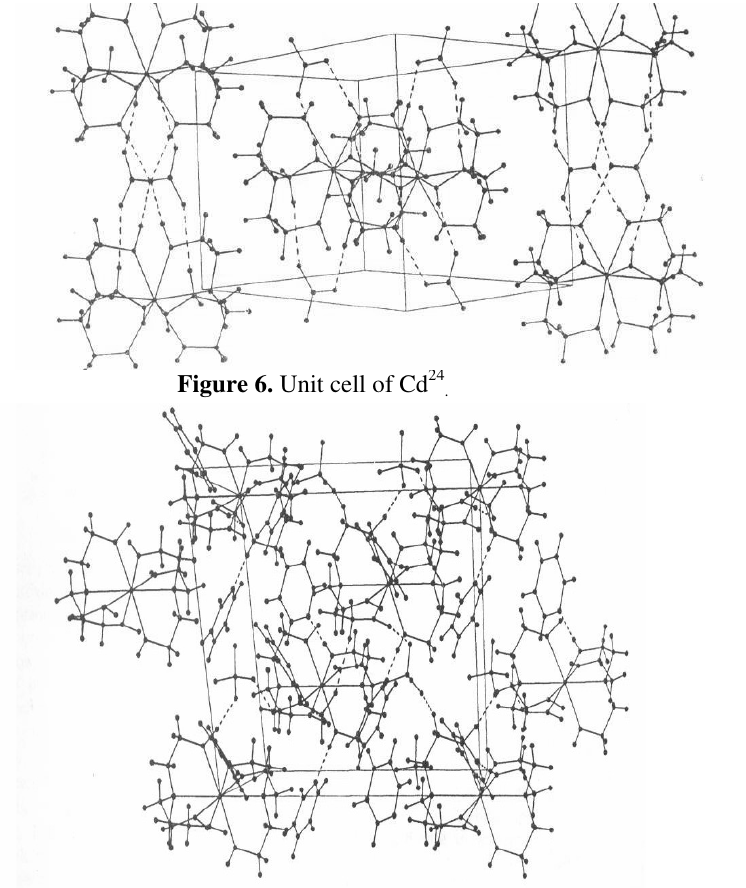
Figure 7. Unit cell of